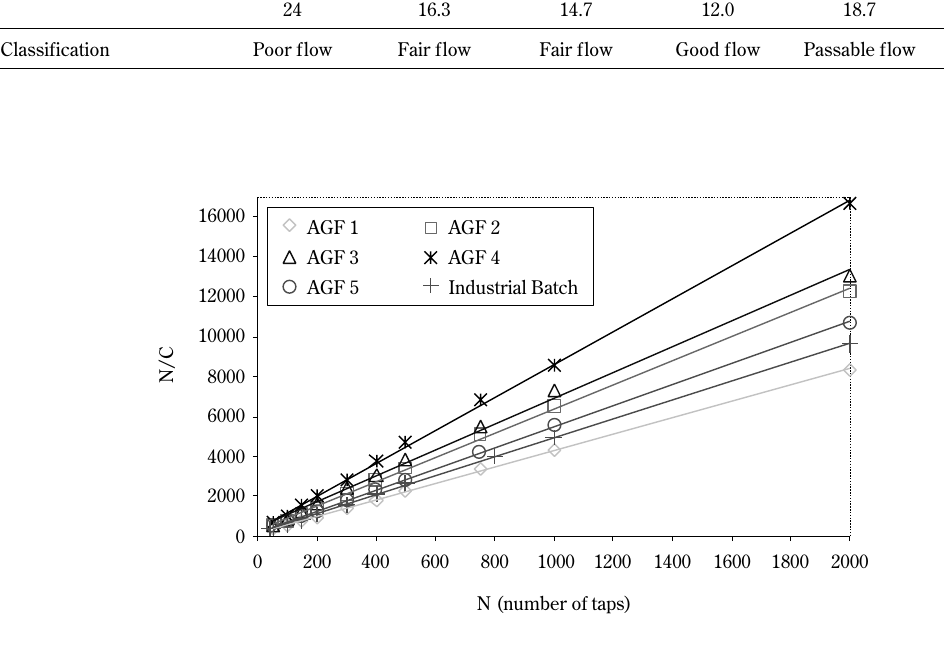
Fig. 11 Relation between N/C and the number of taps